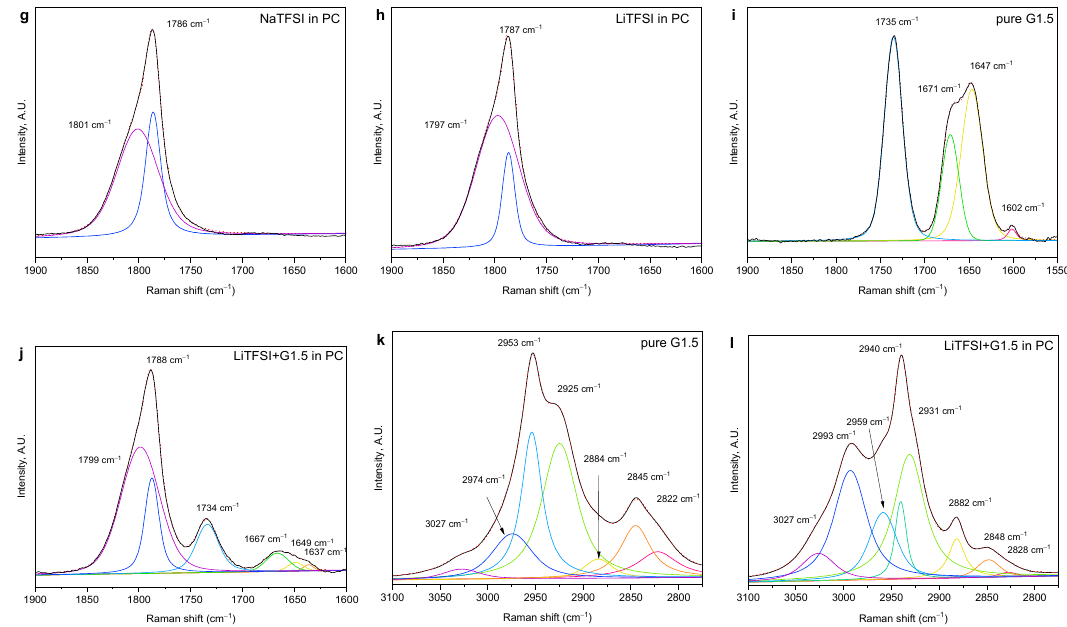
Figure 3. FT-Raman spectra of selected samples in selected spectral regions, including the results of the deconvolution to Lorentzian peaks: pure LiTFSI powder in the region 670–770 cm − 1 ( a ), LiTFSI solution in PC in the region 670–770 cm − 1 ( b ), NaTFSI solution in PC in the region 670–770 cm − 1 ( c ), pure PC in the region 1400–1550 cm − 1 ( d ), NaTFSI solution in PC in the region 1400–1550 cm − 1 ( e ), pure PC in the region 1600–1900 cm − 1 ( f ), NaTFSI solution in PC in the region 1600–1900 cm − 1 ( g ), LiTFSI solution in PC in the region 1600–1900 cm − 1 ( h ), pure G1.5 in the region 1550–1900 cm − 1 ( i ), LiTFSI + G1.5 solution in PC in the region 1550–1900 cm − 1 ( j ), pure G1.5 in the region 2750–3100 cm − 1 ( k ), and LiTFSI + G1.5 solution in PC in the region 2750–3100 cm − 1 ( l ). The experimental spectrum (black line) corresponds to the composition (red dotted line) of individual fitted peaks (other colors) labeled with their Raman shift. (Full FT-Raman spectra can be found in Supporting information Figure S2. All other zoom-ins with the deconvolution results can be found in Figures S3 ‐ 6).